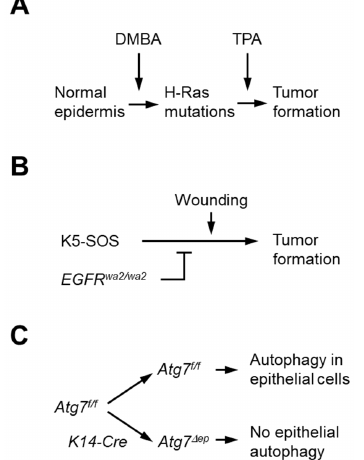
Figure 1. Models for testing the role of Atg7 in tumorigenesis. ( A ) In the two-stage carcinogenesis model, mice were treated with DMBA to initiate tumors through mutations in the oncogene H-Ras. Treatment with TPA in the following 25 weeks promoted tumor growth, which was monitored up to 50 weeks after DMBA treatment. ( B ) In the K5-SOS EGFR wa2/wa2 model, the SOS transgene was expressed in keratinocytes to induce tumors. The waved mutation in EGFR suppressed tumor growth unless it was triggered by wounding of ear skin. Tumors were monitored up to 12 weeks after wounding. ( C ) To determine the role of Atg7-dependent autophagy, an essential segment of the Atg7 gene was flanked by loxP sites ( Atg7 f/f , Atg7 floxed), allowing expression of wild-type (WT)